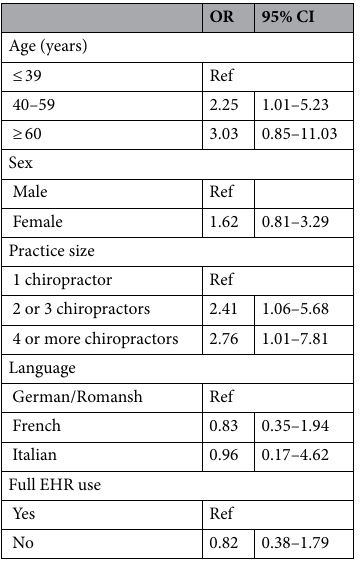
Table 4. Logistic regression model for association of age, sex, practice size, language region and EHR use with motivation (≥ 70 on VAS) to participate in subsequent patient cohort pilot study (n = 152). CI confidence intervals, EHR electronic health record, OR odds ratio, ref reference, y